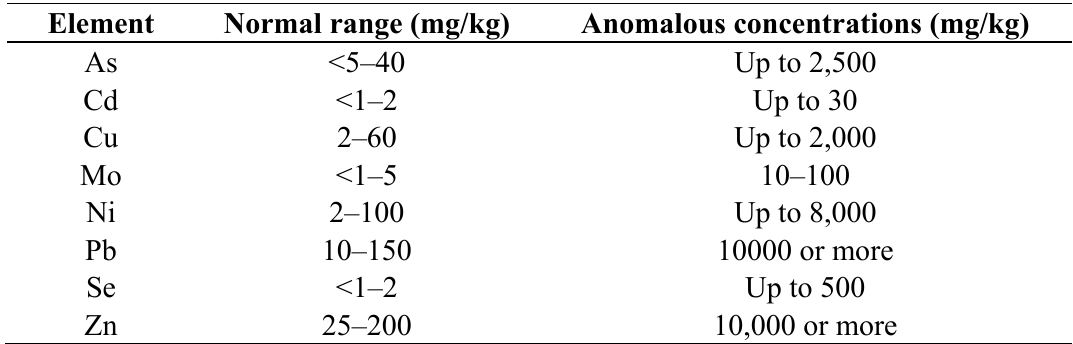
Table 2. Normal and anomalous geochemical concentrations of several trace elements in soils